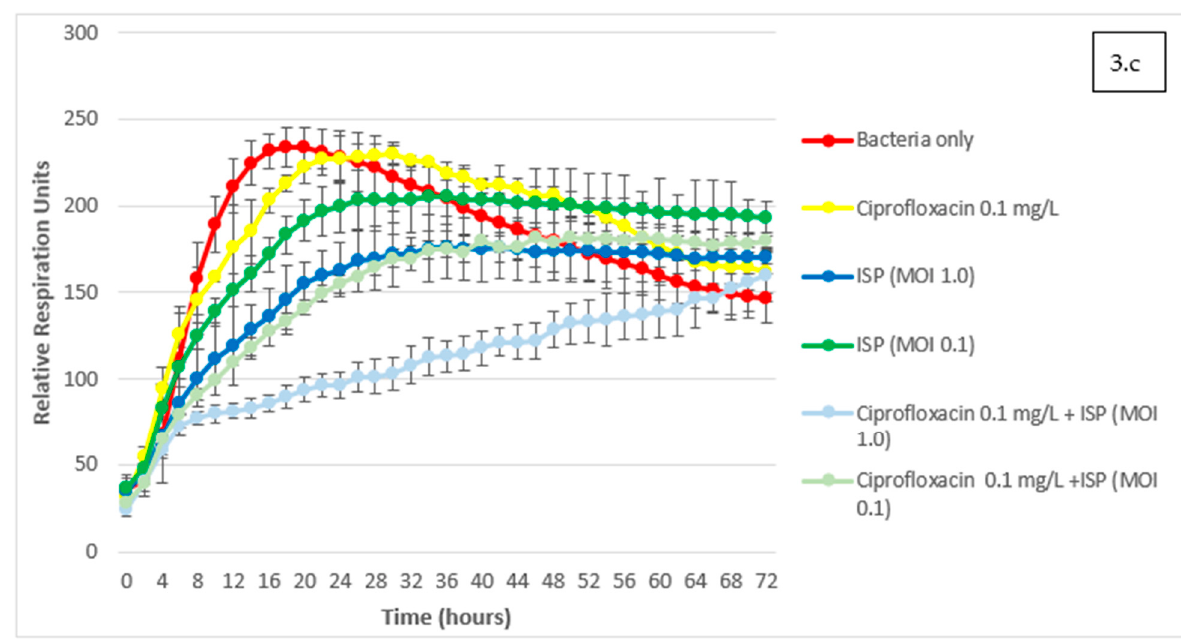
Figure 3. Assessment of phage-antibiotic interactions with the OmniLog ® system. Kinetics of bacterial growth under various conditions are expressed as Relative Respiration Units over a 72 h timeframe. Phage ISP at various Multiplicities of Infection (MOI) was combined with different sub-MIC (Minimum Inhibitory Concentration) concentrations of the three antibiotics that were used concomitantly in the patient: ( a ) clindamycin; ( b ) rifampin; ( c ) ciprofloxacin. Results are presented as mean values of three experiments (biological replicates) with error bars representing standard deviations of the means.